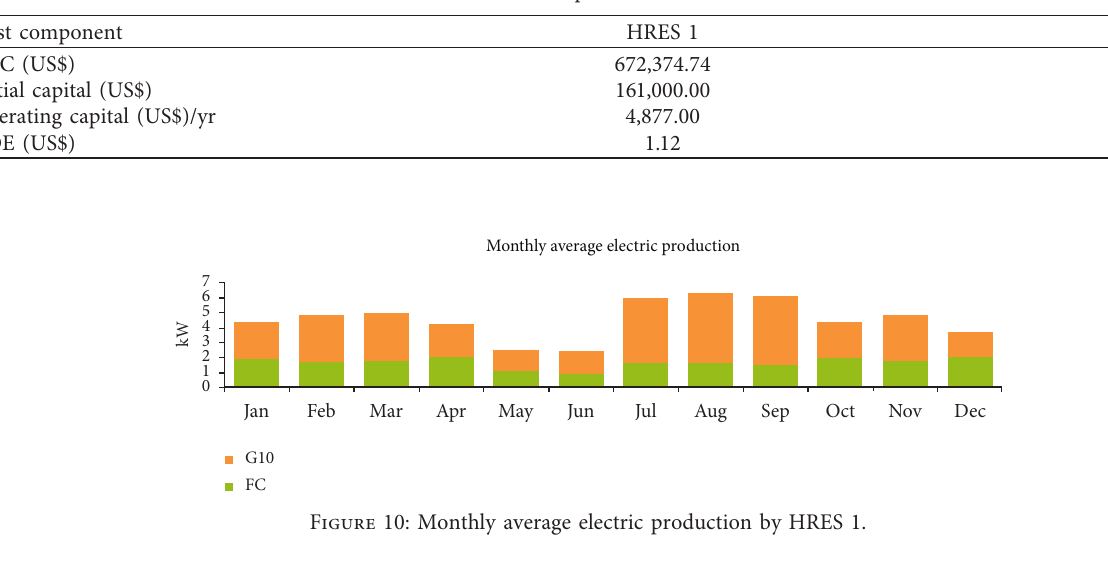
Table 4: Economic comparison of HRES scenarios.